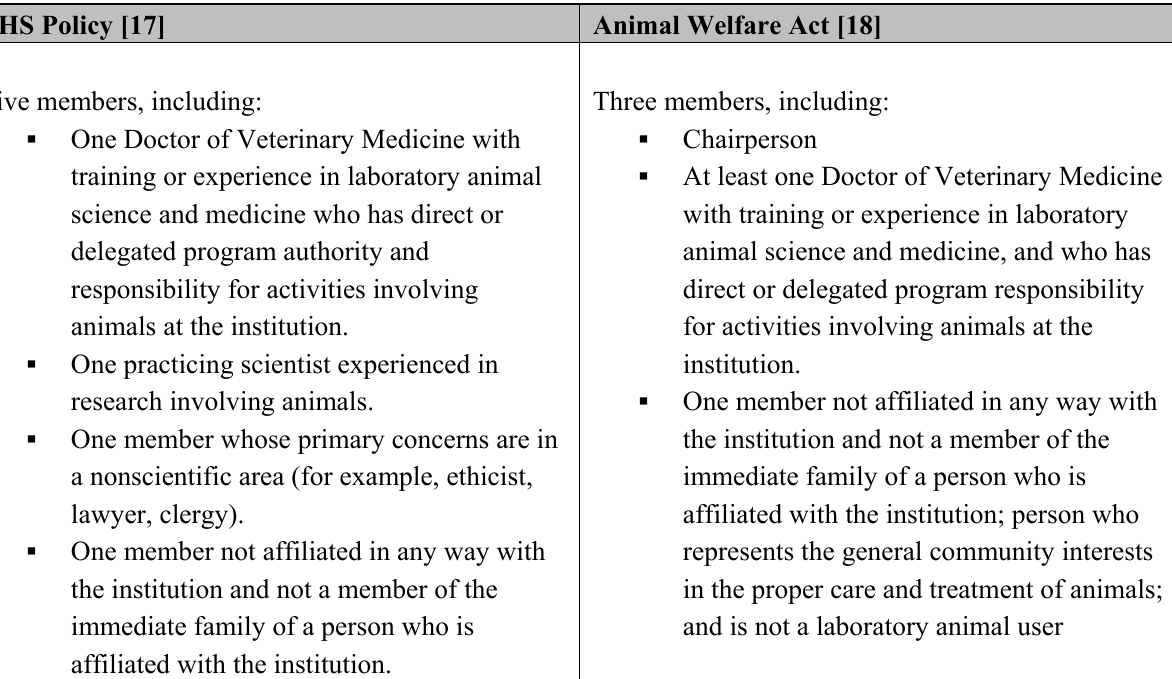
Table 1. Minimum IACUC membership requirements set forth by the Public Health Service and